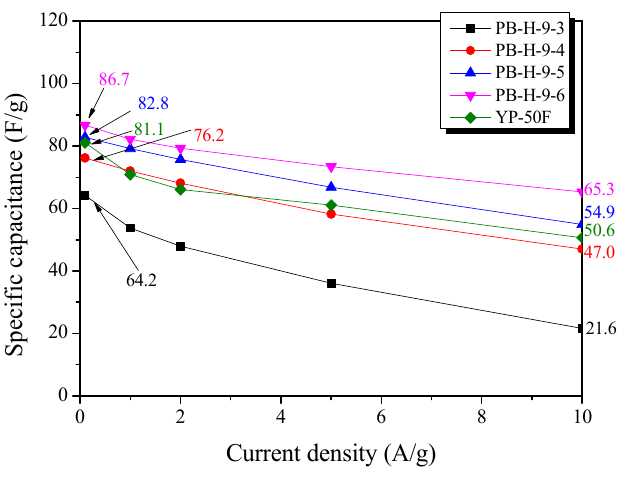
Figure 7. Specific capacitance of PB-AC as a function of discharge current density. At a current density of 0.1 A/g, YP-50F and PB-H-9-5 have similar specific capac- itances, but, at a current density of 10 A/g, the specific capacitance of PB-H-9-5 (5–400 mV/s). The current densities in the CV curves are normalized with respect to the